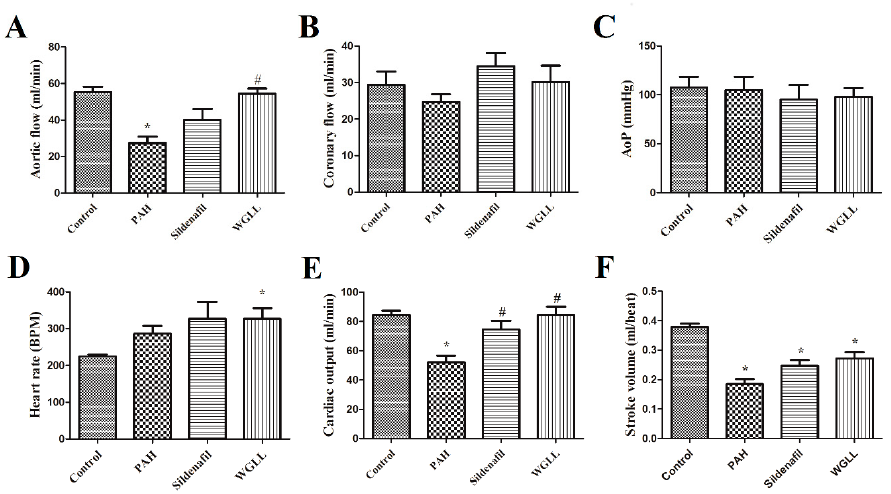
Figure 1. Effects of four treatments on cardiac functions in rats measured ex vivo by isolated working heart method. Treatment groups included Control, PAH (pulmonary arterial hypertension) group, Sildenafil-injected group, and Wild garlic ( Allium ursinum ) liophylisate-enriched chow